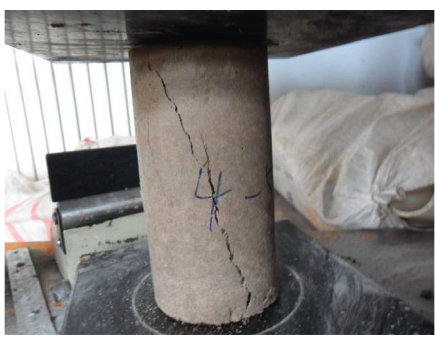
Figure 4: Strength test for backfill